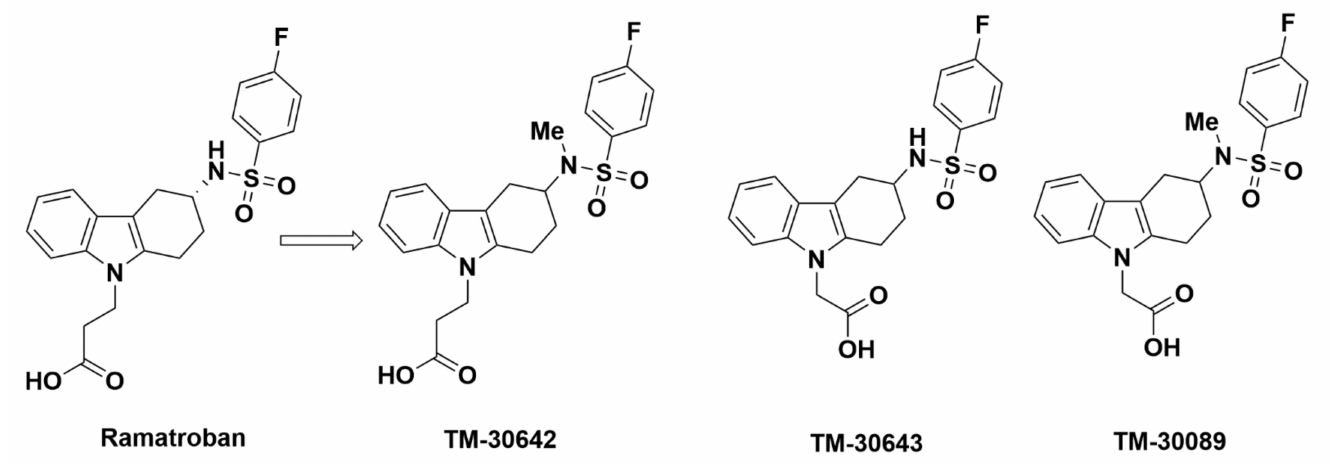
Figure 5. Molecular structures of TM-30642, TM-30643 and TM-30089. TM-30642